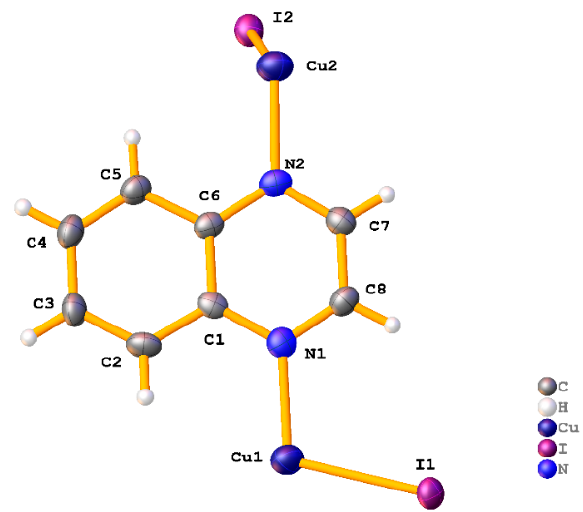
Figure 1. Thermal ellipsoids plot (50%) and labeling scheme for compound [(CuI) 2 (Quin)] at ambient conditions.